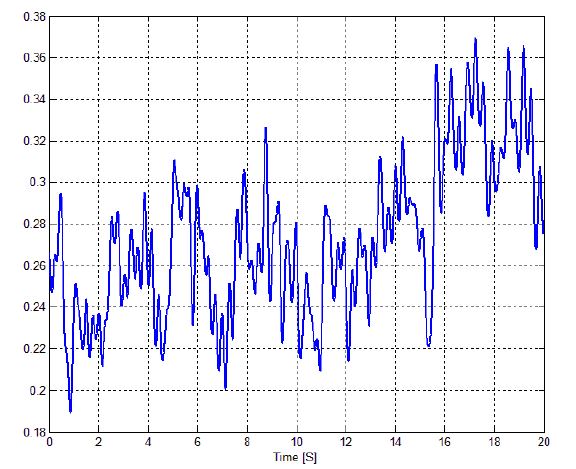
Figure 9. The profile of wavelet scalogram related to acceleration in flight direction at 12 Hz